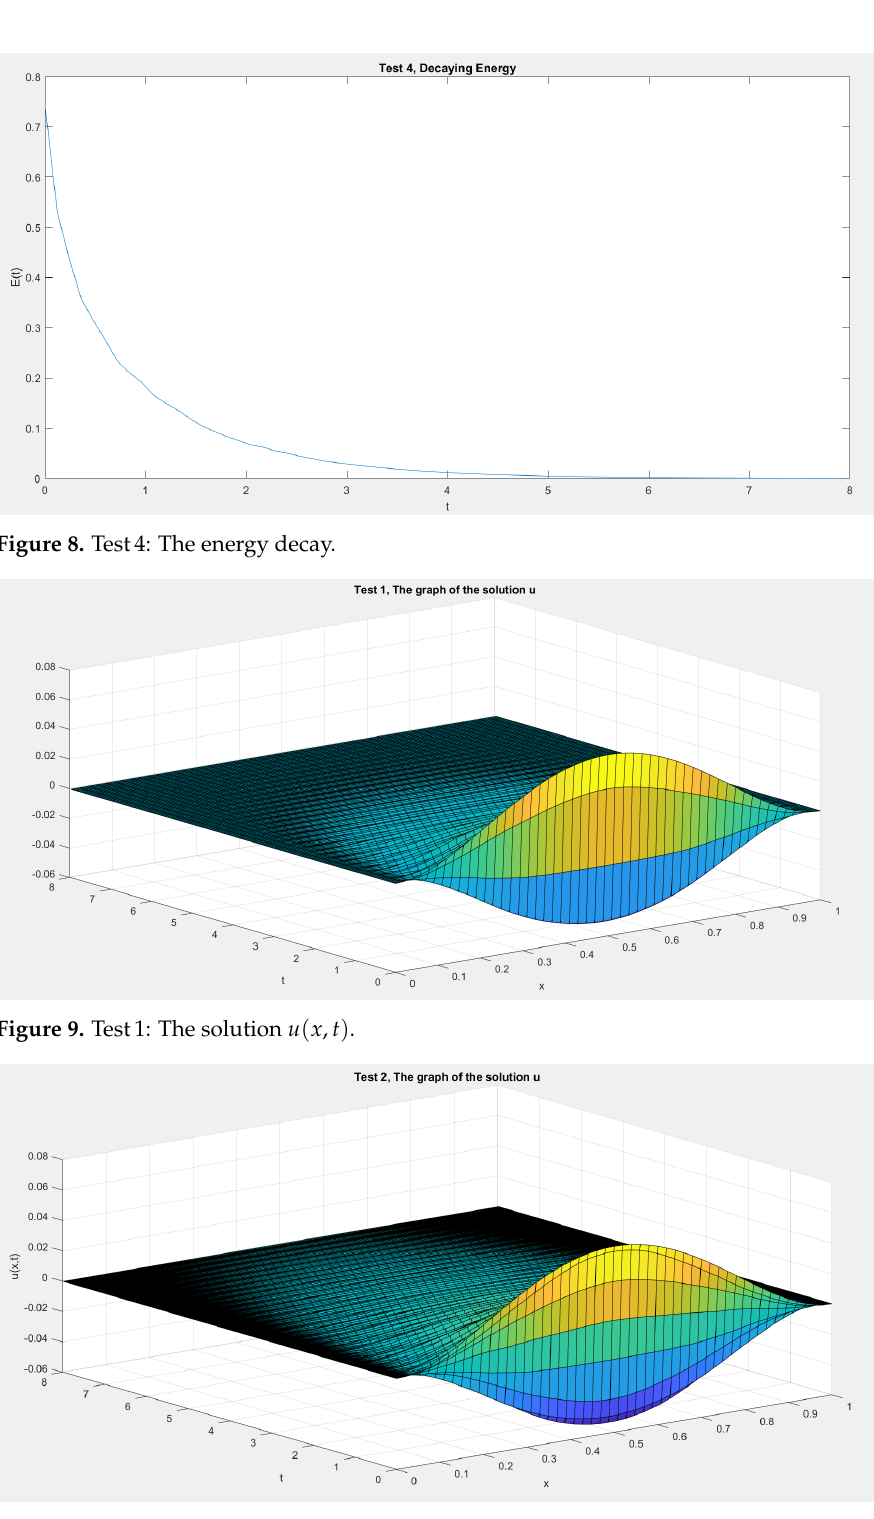
Figure 10. Test2: The solution u ( x , t )